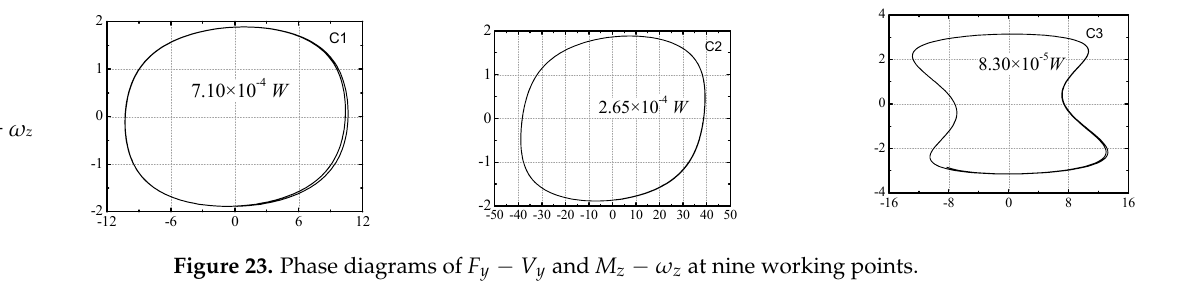
Figure 24. Sketch of forces on flapping foil.